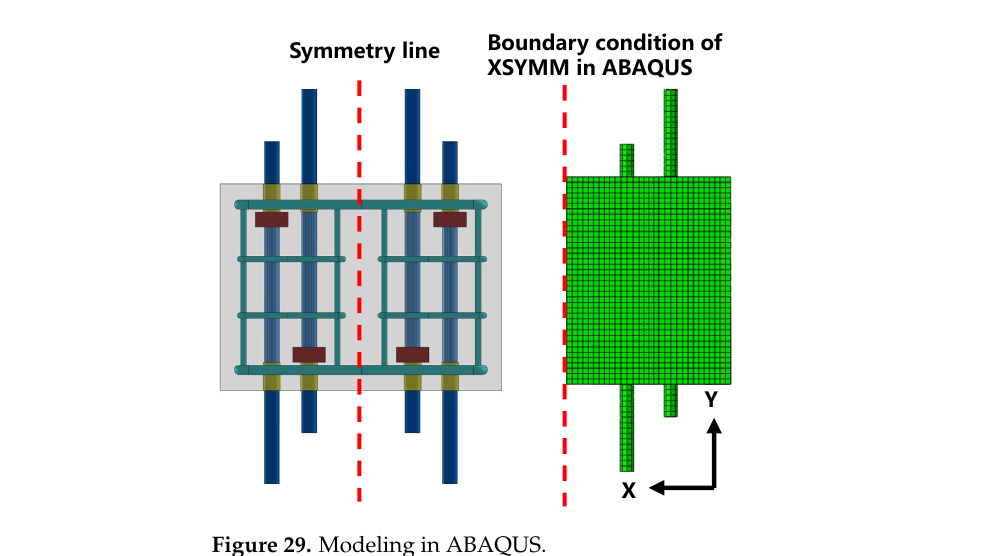
Figure 29. Modeling in ABAQUS.